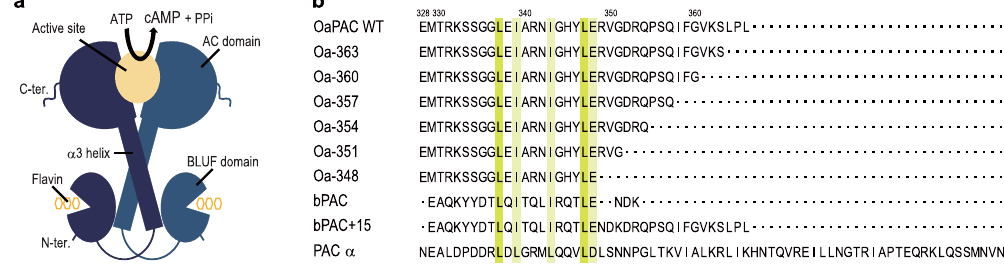
Figure 1. Structure of OaPAC, and amino acid sequences of the C-terminal region of PACs and their mutants. ( a ) Schematic representation of OaPAC. ( b ) Amino acid sequences of the C-terminal region of OaPAC (NCBI, WP_015149803.1), deletion mutants of OaPAC (Oa-363, Oa-360, Oa-357, Oa-354, Oa-351, and Oa-348), bPAC (GenBank: GU461306.2), bPAC mutant (bPAC + 15), and PAC α -chain from Euglena gracilis (PAC α ). Amino acids highlighted in yellow represent conserved